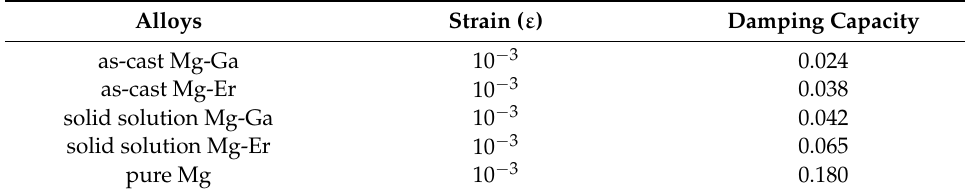
Figure 4. ( a ) The damping curves of as-cast, solid solution Mg-Ga alloy and pure Mg; ( b ) the damping curves of as-cast, solid solution Mg-Er alloy and pure Mg. Table 2. The damping capacity of four binary Mg-X (X = Ga and Er) alloys and pure